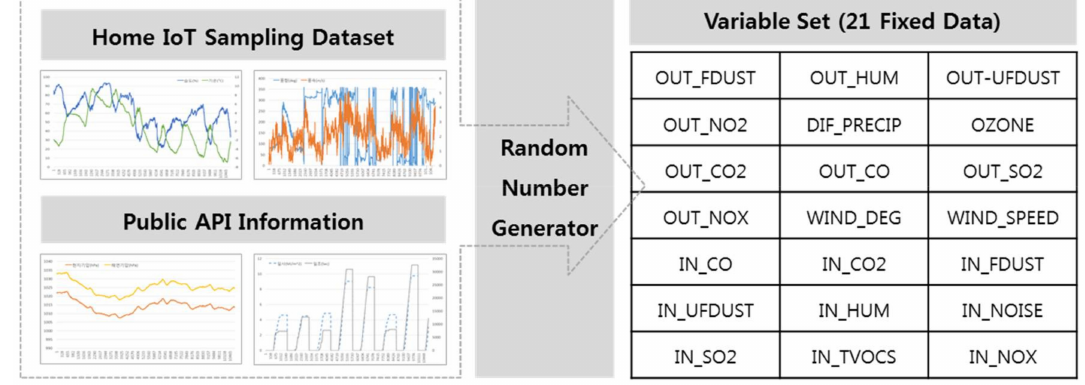
Figure 3. Random number generation.